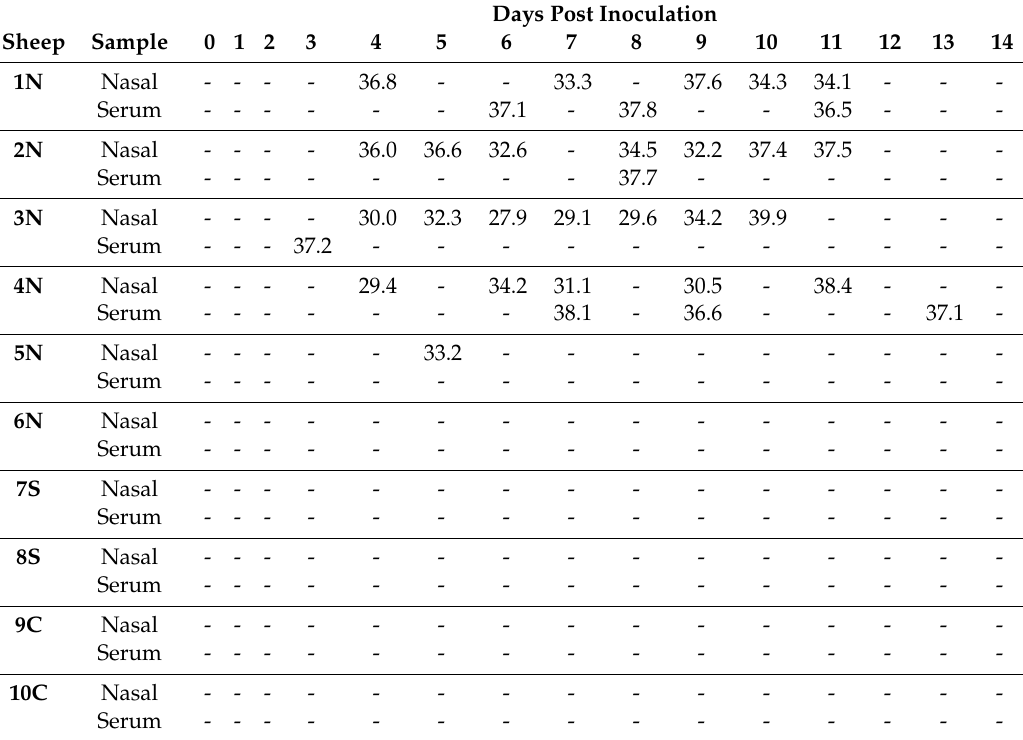
Table 1. Bungowannah virus qRT-PCR results from sheep intranasally and subcutaneously inoculated. Days Post